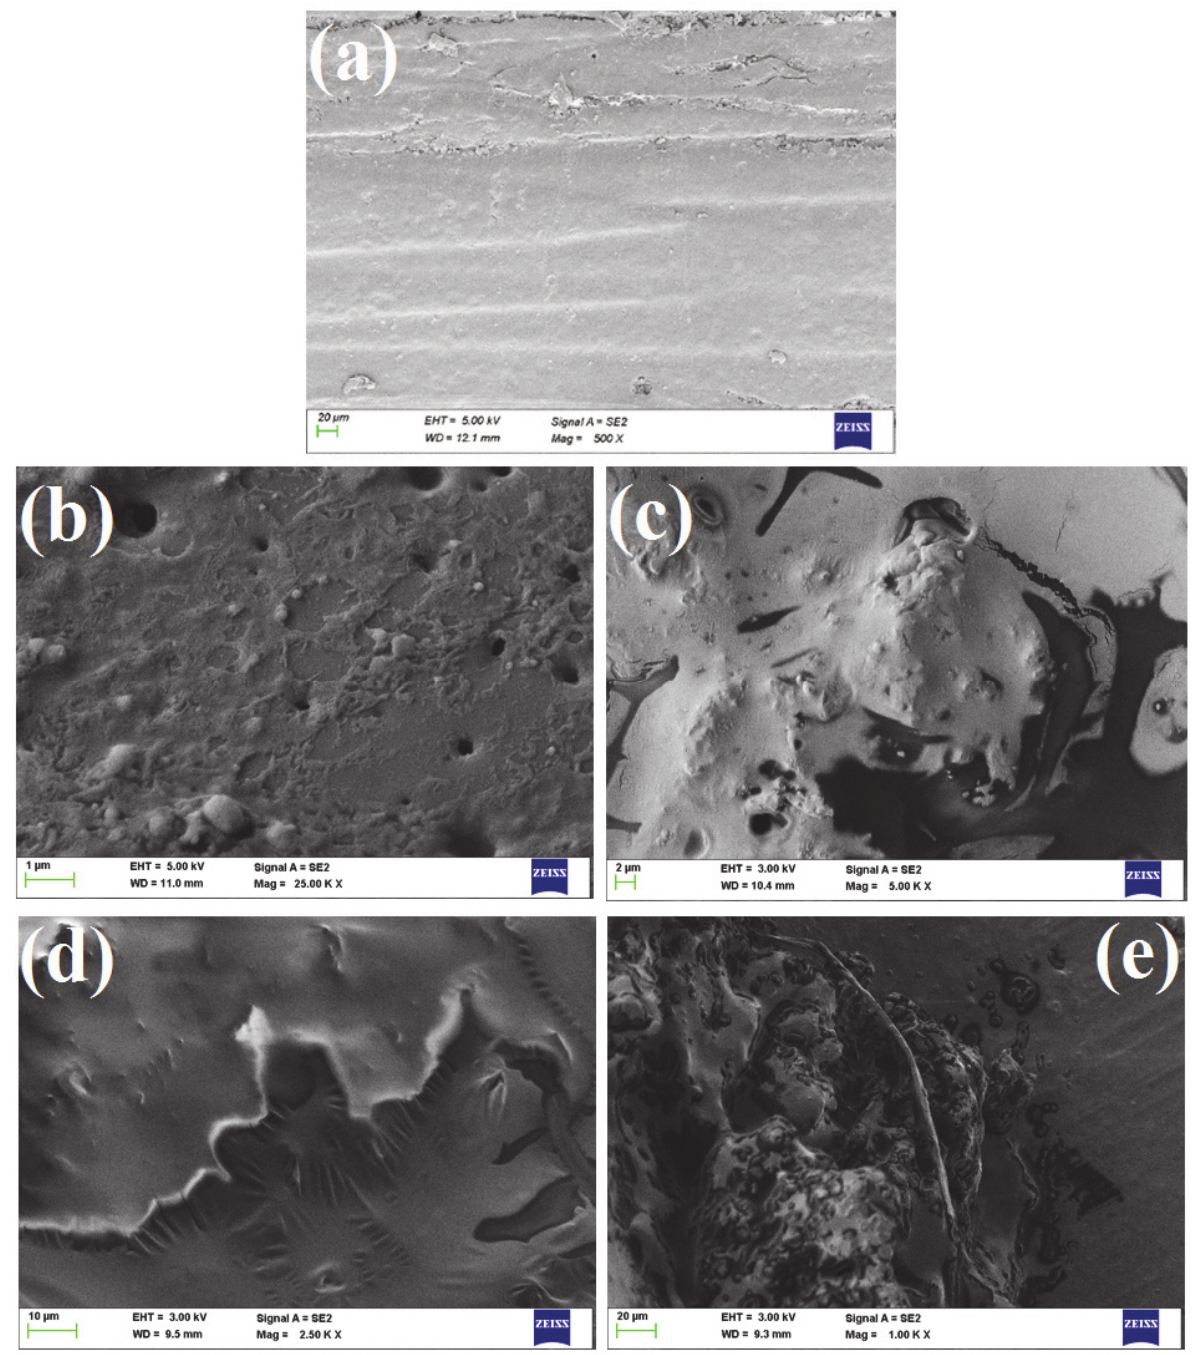
Figure 8: SEM micrographs of fracture surfaces from tensile tests of (a) S0 (b) S1 (c) S2 (d) S3 (e) S4. Simulation